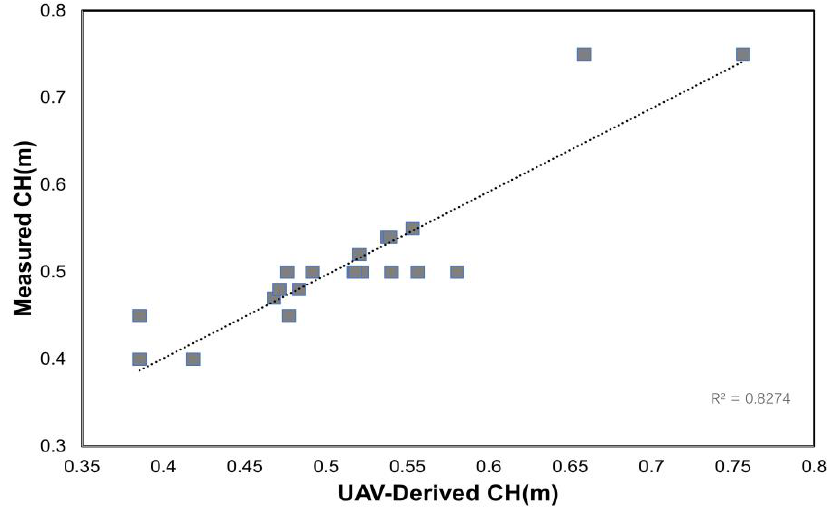
Figure 4. Comparison of measured canopy height from 22 vineyards on May 23,